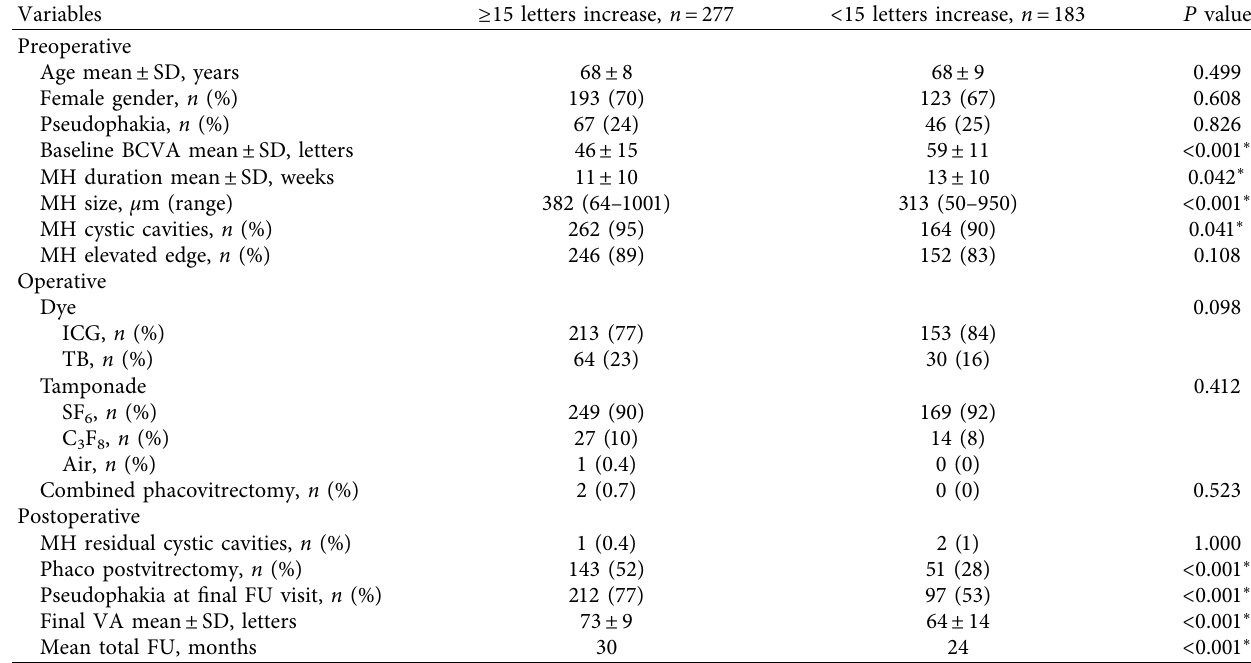
Table 2: Baseline, intraoperative, and postoperative characteristics in the eyes with increase ≥ 15 ETDRS letters following primary vit- rectomy for idiopathic full-thickness macular hole between baseline and final